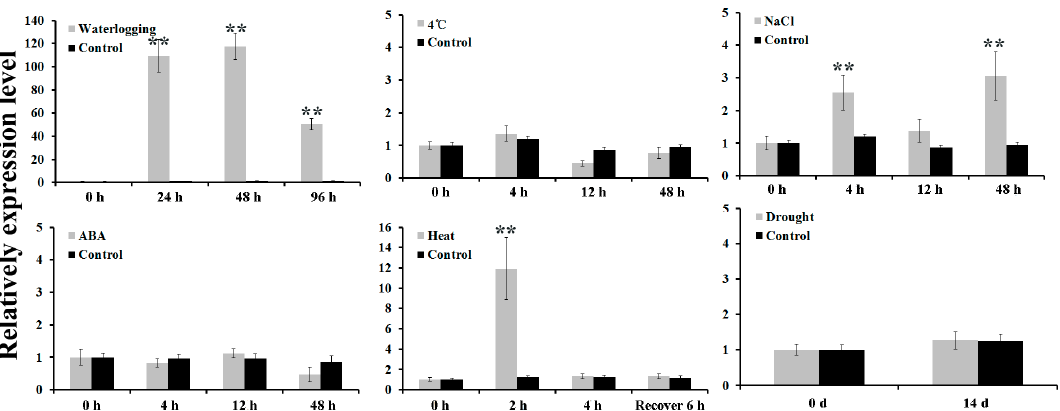
Figure 2. Expression patterns of AdPDC2 in roots under waterlogging stress and in leaves under NaCl (200 mM), 4 °C, ABA (0.01 mM, Sigma, St. Louis, MO, USA), heat (incubated at 48 °C for 2 h and 4 h, then subsequently at 23 ± 1 °C for another 6 h), drought stresses (watering was withheld 14 d), and corresponding non-treatment plants (control) were assessed using qRT-PCR. AdActin was used as an internal control. Each column is the average of three replicates and each replicate has 15 plants. Bars indicate SD. Double asterisks indicate significant differences compared with non-treatment (0 h) values ( ** p < 0.01).